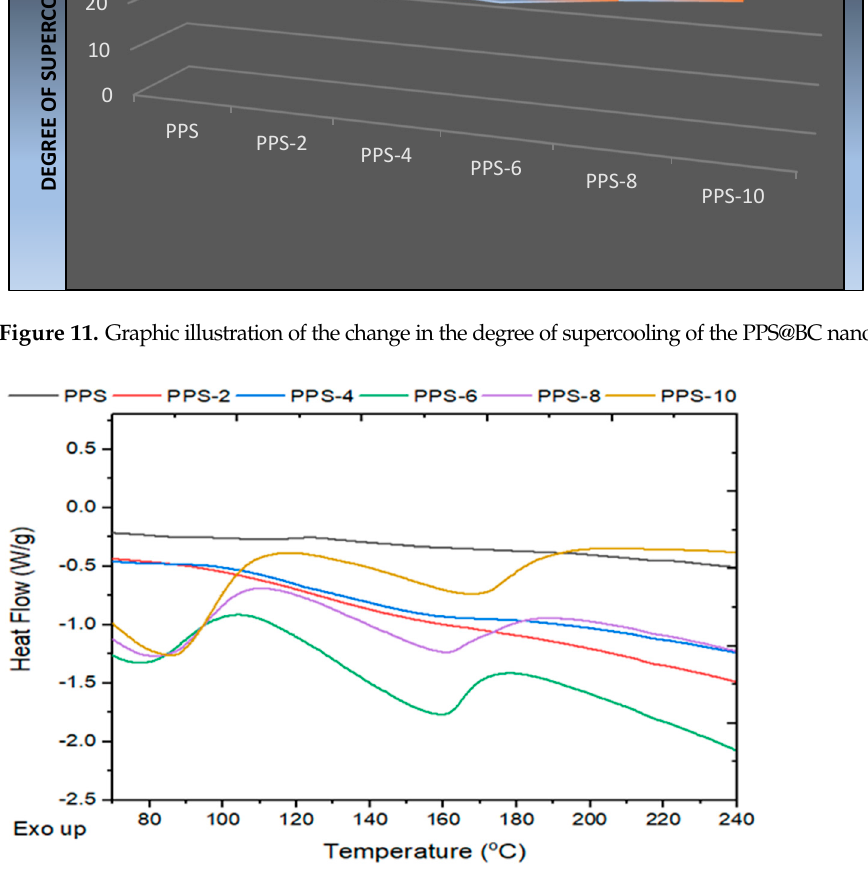
Figure 12. Glass transition analysis of the PPS@BC nanocomposites.